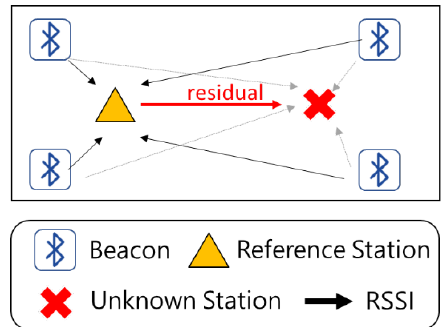
Figure 3. The diagram of differential distance